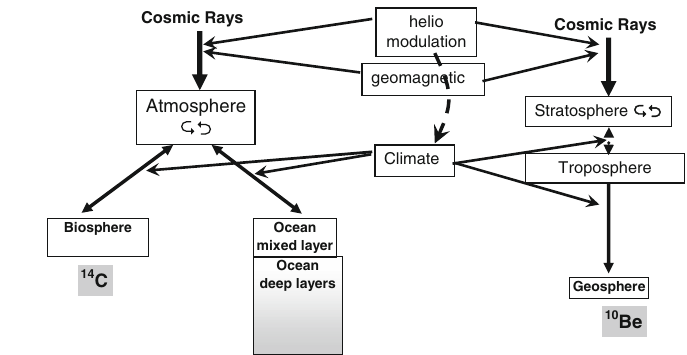
Fig. 7 Schematic representation of 14 C ( left ) and 10 Be ( right ) production chains. The flux of cosmic rays impinging on the Earth is affected by both heliospheric modulation and geomagnetic field changes. The climate may affect the redistribution of the isotopes between different reservoirs. Dashed line denotes a possible influence of solar activity on